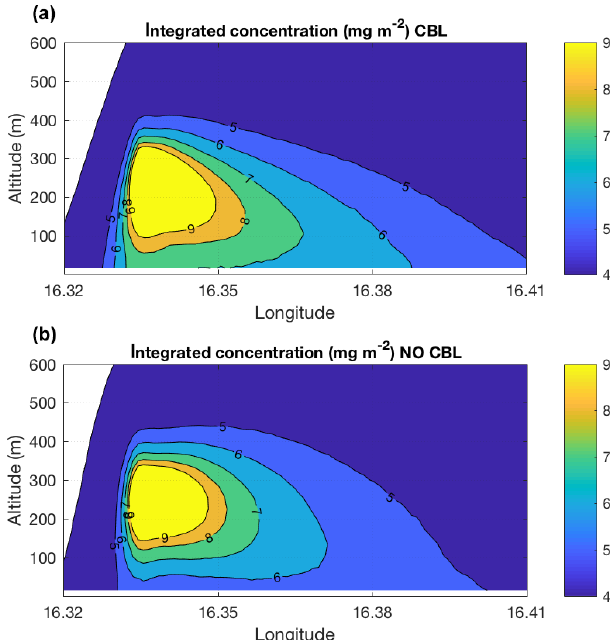
Figure 1. Comparison of FLEXPART results obtained with the skewed turbulence parameterization (a) and with the Gaussian tur- bulence parameterization (b) . Shown are the tracer concentrations integrated over all latitudes as a function of altitude and longitude. The simulations used a point source emitting 100kg of tracer per hour for a period starting on 1 July 2017 at 12:00UTC and end- ing at 13:30UTC. The source was located near Vienna (Austria) at 47 . 9157 ◦ N and 16 . 3274 ◦ E, 250m above ground level. Results are averaged for the time period 12:40 to 13:00UTC. Notice that the maximum ground-level concentration in panel (a) (ca. 7mgm − 2 ) is about 30% higher than in panel (b) (5mgm − 2